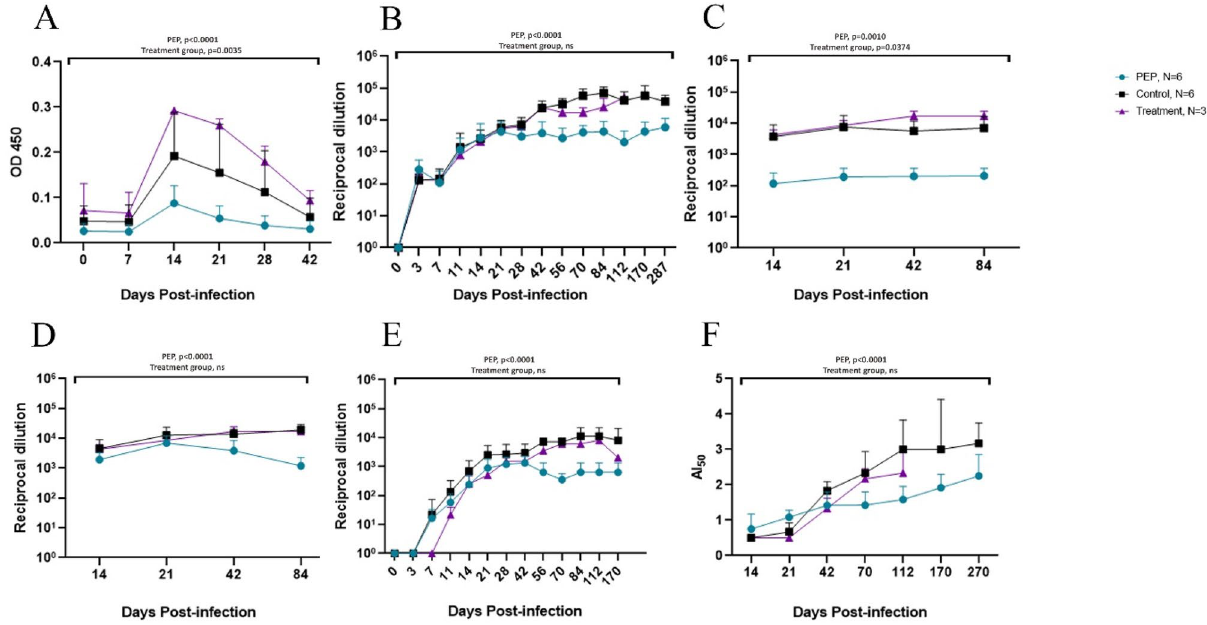
Figure 6. MeV-specific humoral immune response in MeV-infected macaques treated with remdesivir as compared to untreated controls. ( A ) IgM; ( B ) IgG; ( C ) Antibody to the H glycoprotein; ( D ) Antibody to the N protein; ( E ) Plaque reduction neutralization titer; ( F ) Avidity